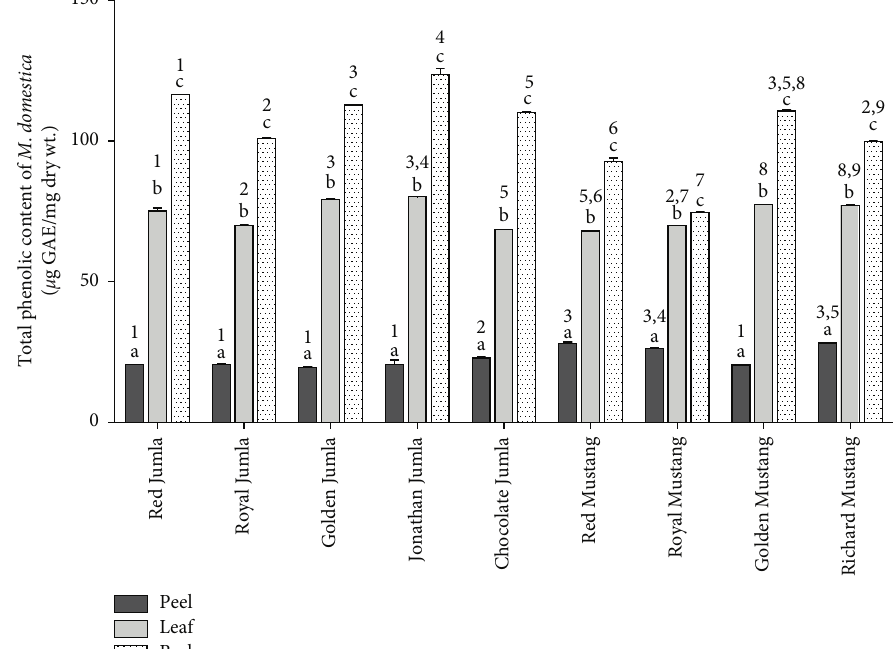
Figure 1: Total phenol content of methanolic extract of peel, leaf, and stem bark in different M. domestica cultivars from two different regions of Nepal. Different letters (a–c) on bars indicate significant differences ( P < 0 . 05) between peel, leaf, and bark within the same cultivar. Different numbers (1–9) on bars indicate significant differences ( P < 0 . 05) among the cultivars for same plant parts (peel, leaf, or bark).